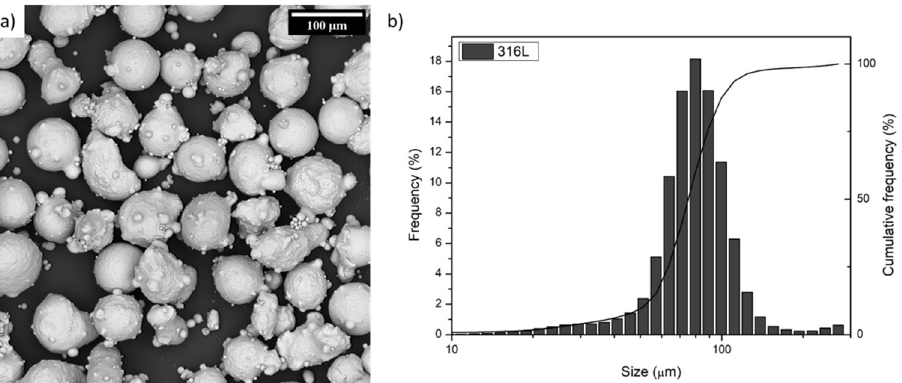
Figure 1. ( a ) SEM image and ( b ) particle size distribution of the as-received 316L powder.